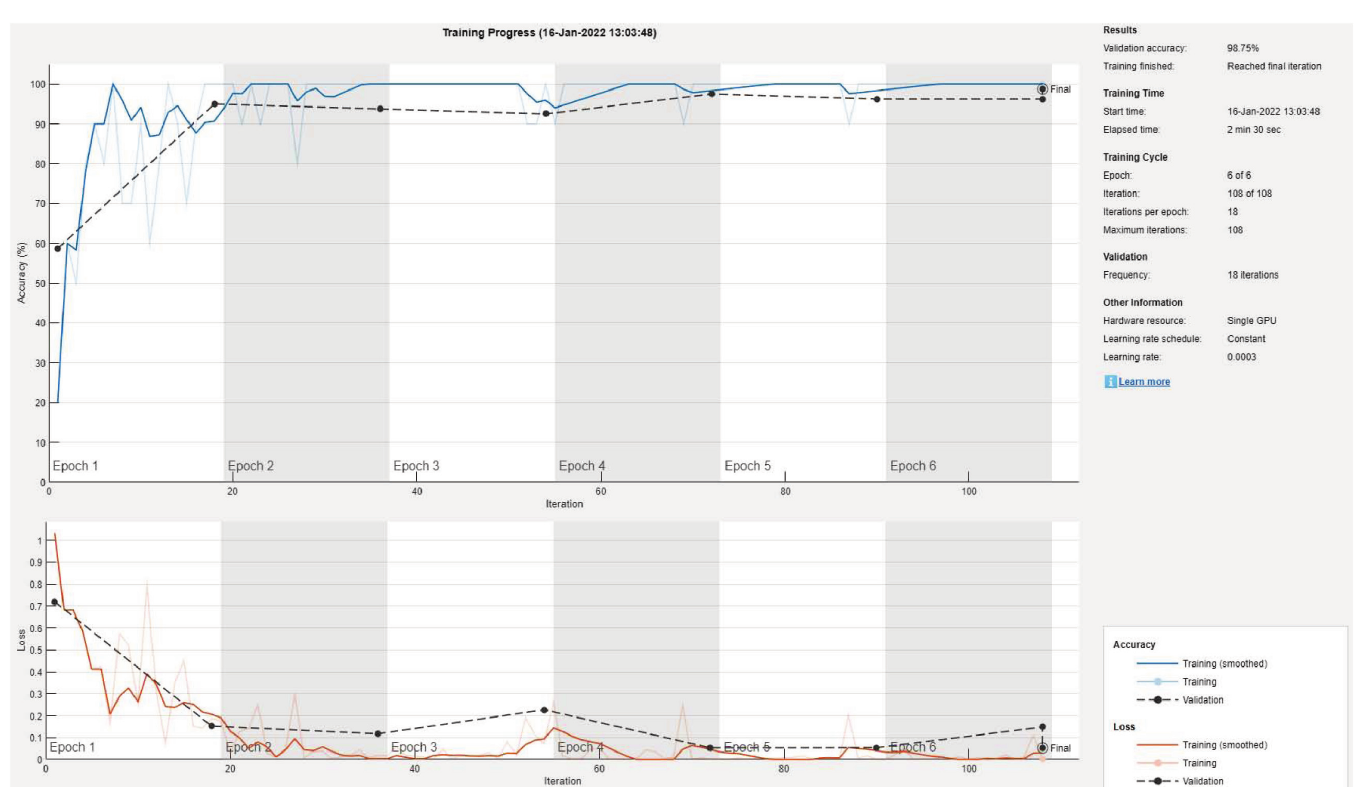
Fig 9. The DenseNet-201 sample training and validation curve for scoliosis vs spondylolisthesis